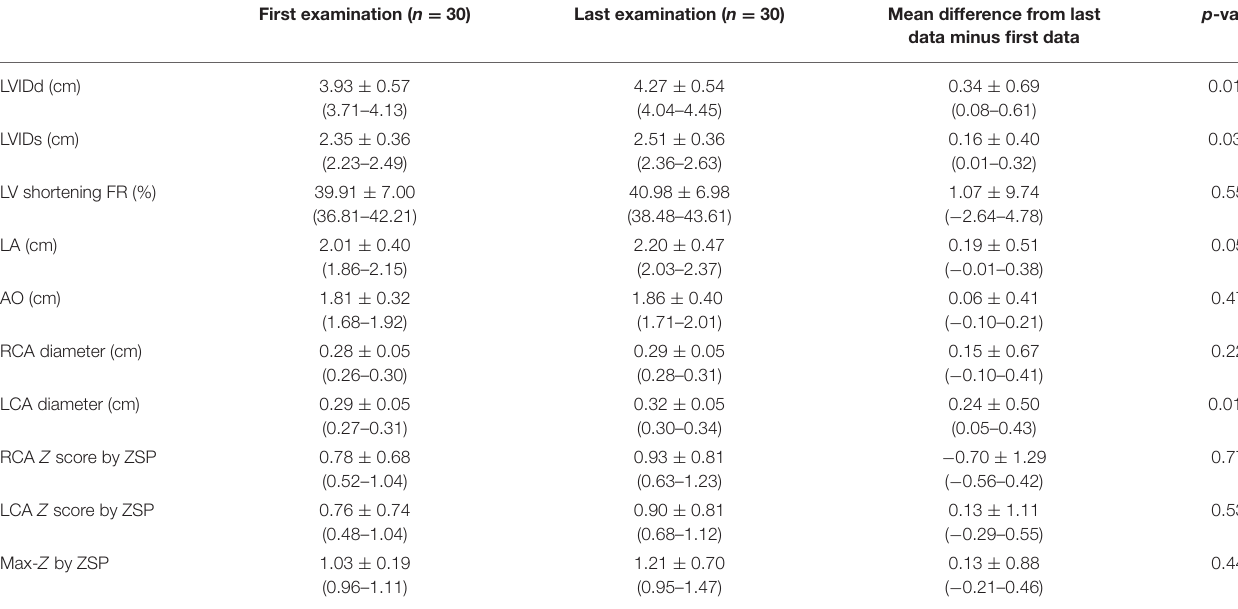
TABLE 3 | Corresponding echocardiogrpahic findings of the first and the last cardiopulmonary exercise testing in participants with Kawasaki disease. First examination ( n = 30) Last examination ( n = 30) Mean difference from last